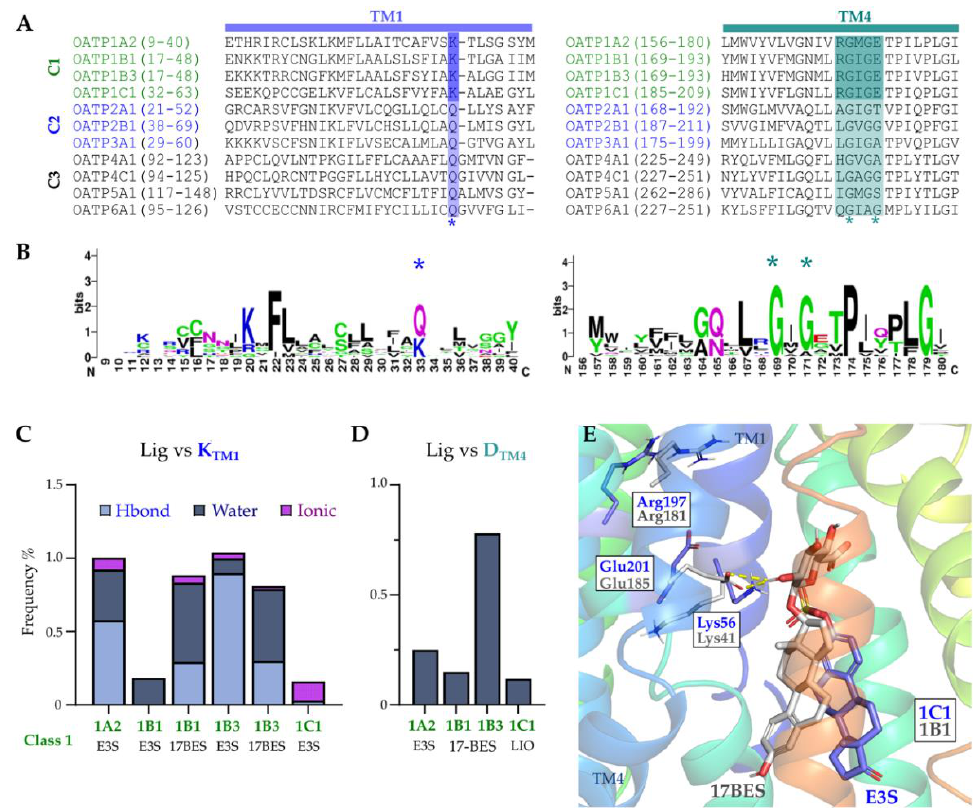
Figure 7. ( A ) Alignment of OATPs showing TM1 (left) highlighting the Lysine residue in violet and TM4 (right) highlighting the Arginine and glutamate. ( B ) HMM-logos showing the conservation of highlighted residues. ( C ) Interaction frequency of ligands with conserved Lysine on TM1. ( D ) Interaction frequency of ligands with Glutamate on TM4 (water interactions). ( E ) Binding pose of 17BES in OATP1B1 (grey) and E3S in OATP1C1 (violet) showing interactions with Glu185 and Lys56, respectively. Conserved amino acids are indiacted with * in A and